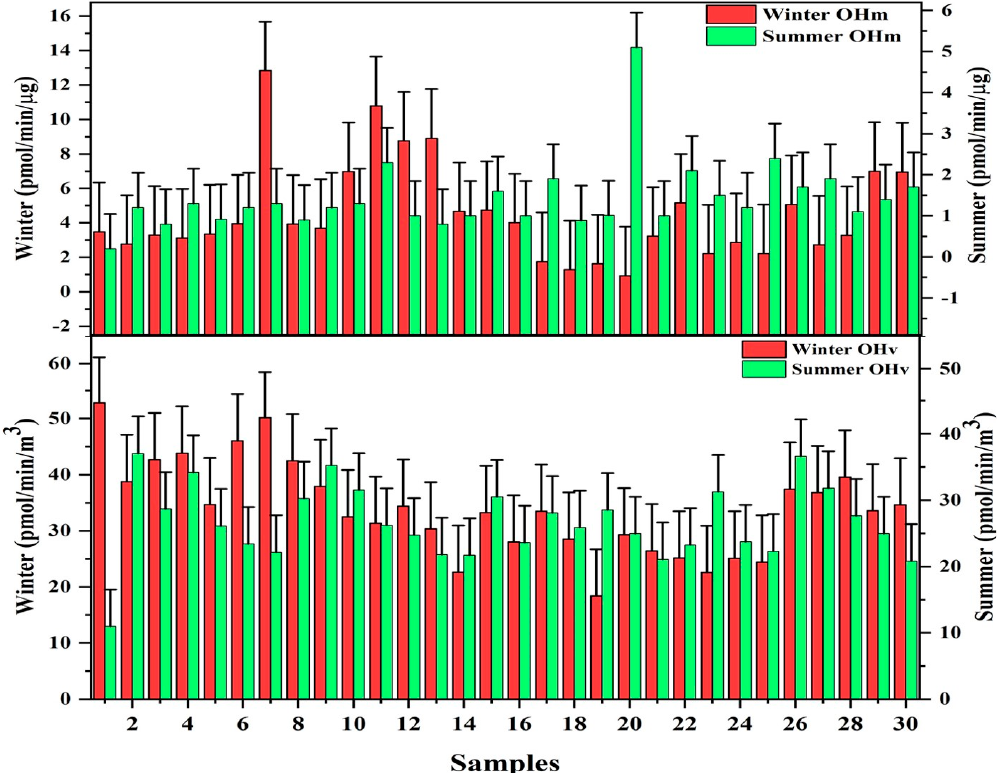
Figure 2. Hydroxyl radical ( • OH) generation rate in the atmosphere and PM 2.5 mass in Lahore during the sampling period of winter and summertime, 2019.